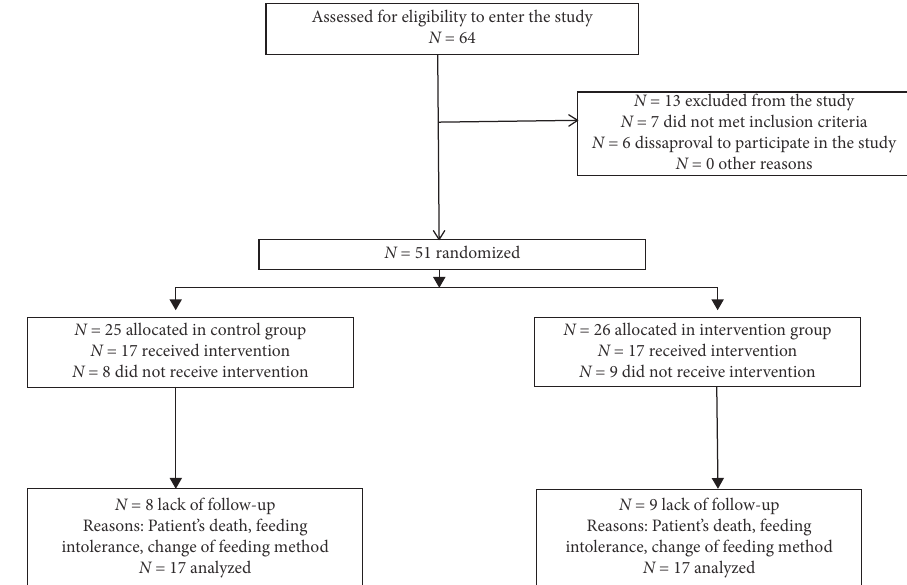
Figure 1: Flow diagram of the study. Table 1: Comparison of baseline information between intervention and control groups.